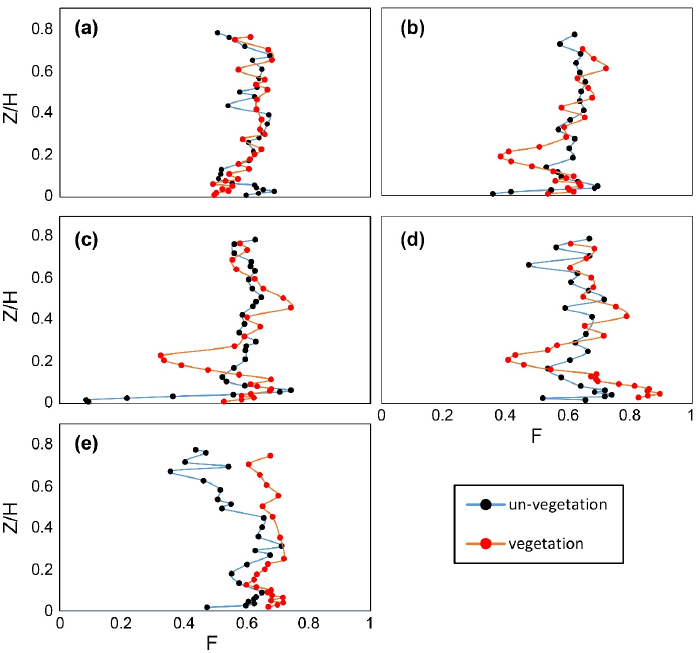
Figure 21. Evolution of the invariant function ( F ) at the azimuthal sections of θ = ( a ) 30 ◦ , ( b ) 60 ◦ , ( c ) 90 ◦ , ( d ) 120 ◦ , and ( e ) 160 ◦ for the cases of the un-vegetated bed and the vegetated bed at an equal distance of 4 cm from the abutment.